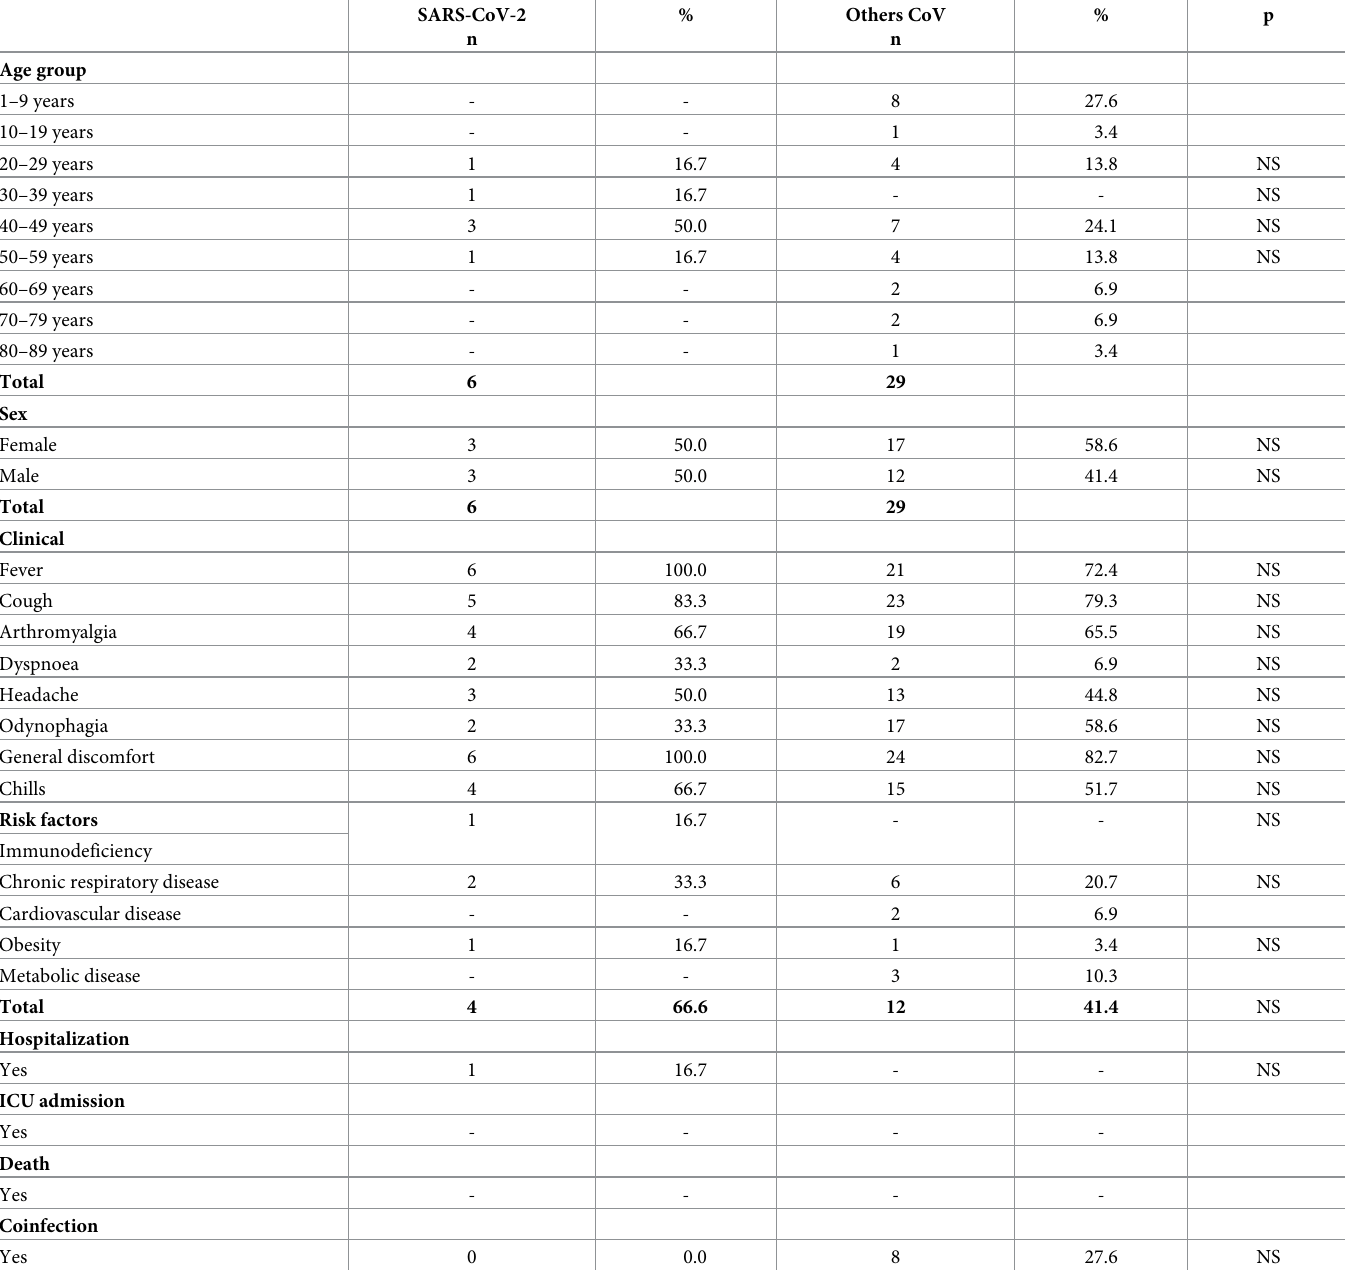
Table 2. Clinical and epidemiological characteristics of SARS-CoV-2 and other CoV. Catalonia, October 2019-April 2020. SARS-CoV-2